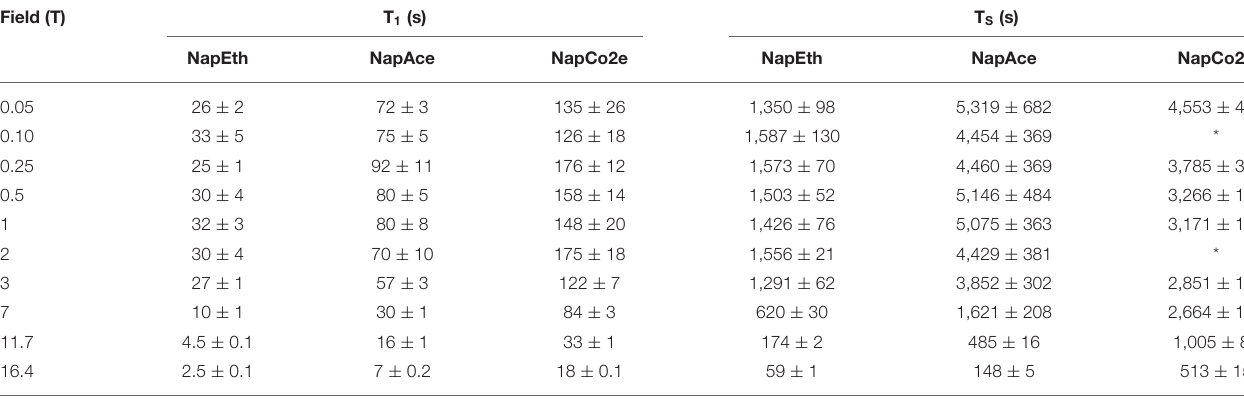
TABLE 3 | T 1 and T S values for samples NapEth , NapAce, and NapCo2e obtained at 20 ◦ C and different magnetic field strengths.